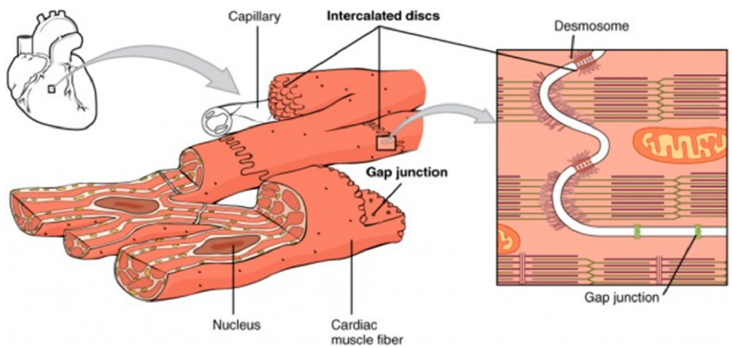
Figure 2. Structure of the myocardium functional unit. Reproduced from [30], Creative Commons Attribution License. Table 1. Structural and functional comparison between key features of skeletal and cardiac muscle.